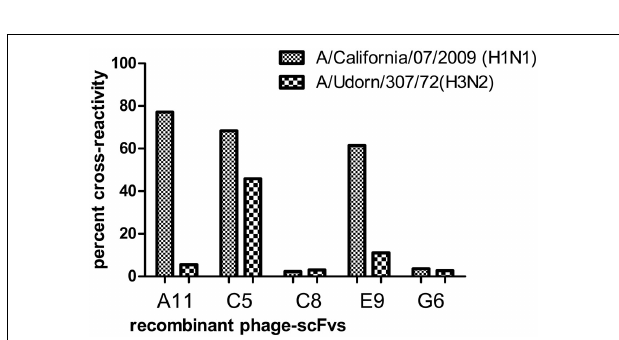
FIGURE 6 | Assessment of cross-reactivity of the relatively high affinity anti-HA (A/New Caledonia/20/99(H1N1) virus) monoclonal rAbs against the other influenza A virus sub-types, A/California/07/2009 (H1N1)-like and A/Udorn/307/72(H3N2) viruses . The ELISA absorbance value for each of the cross-reactive strains was divided by that of the specific strain and multiplied by 100 to generate the percent cross-reactivity.